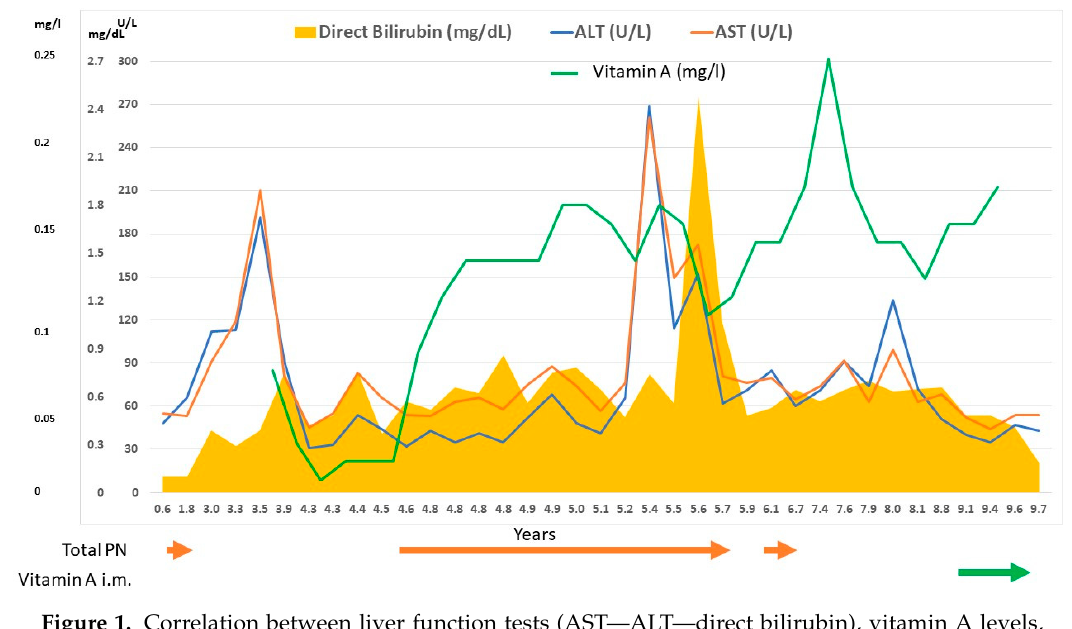
Figure 1. Correlation between liver function tests (AST—ALT—direct bilirubin), vitamin A levels, parenteral nutrition (PN) administration and vitamin A supplementation .